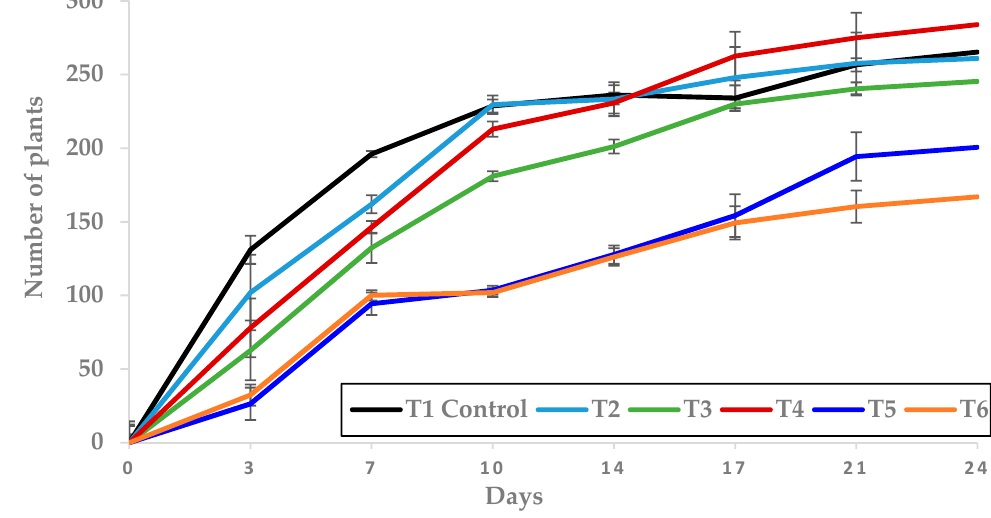
Figure 8. Effect of T1 to T6 treatments applied in pre-emergence on the number of plants grown (mean ± standard error) in the trays where they were applied.